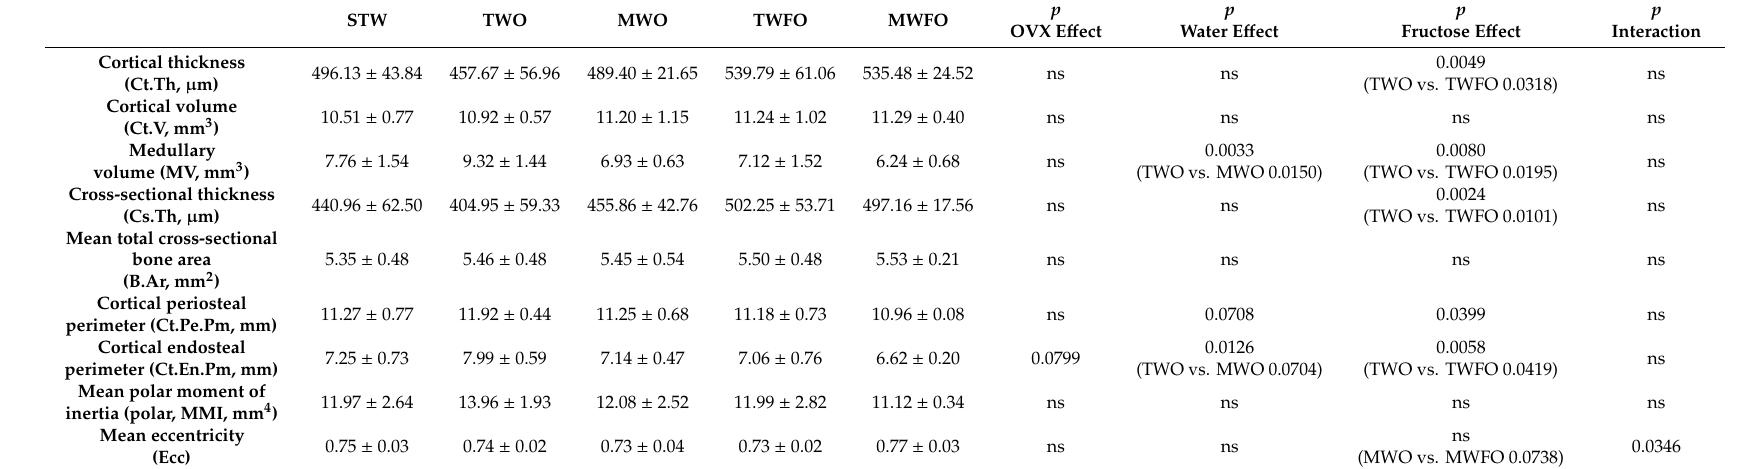
Table 2. Cortical bone region (rat distal femur) evaluation of microstructural properties by microcomputed tomography. STW TWO MWO TWFO MWFO